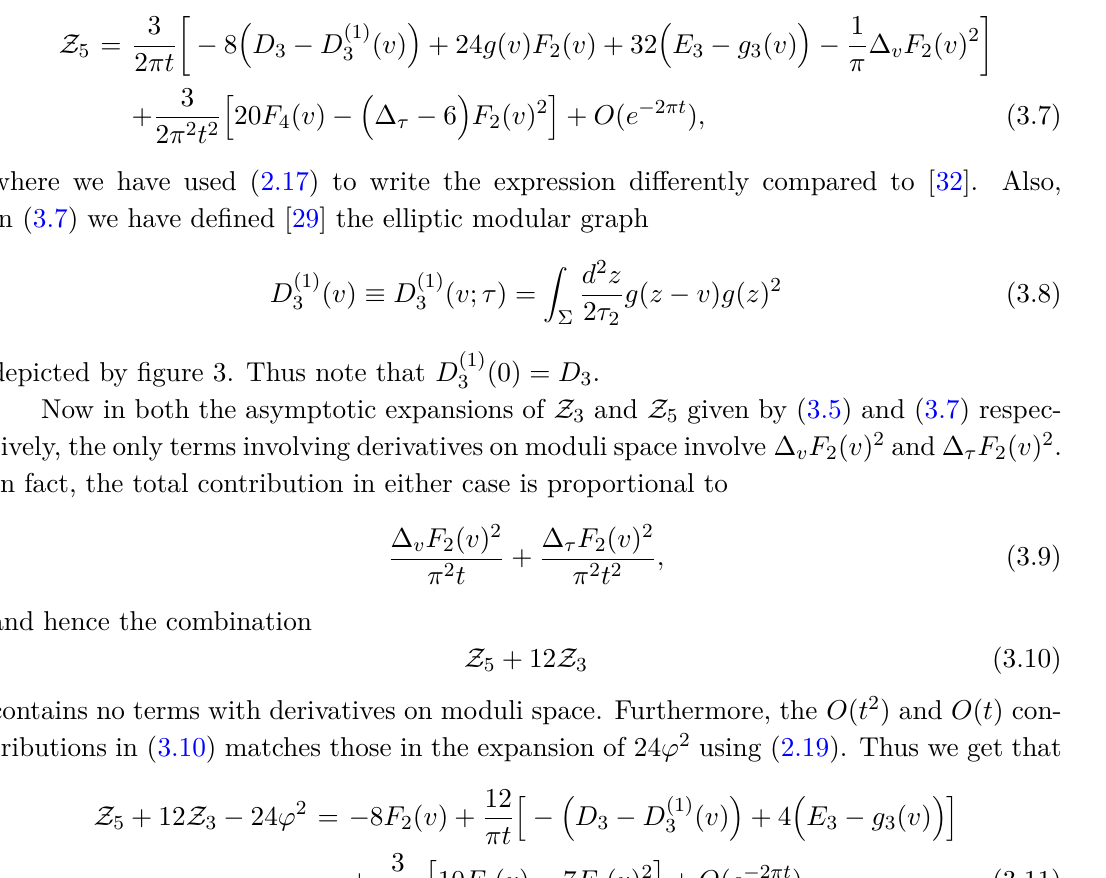
Figure 3 . The elliptic modular graph D (1)